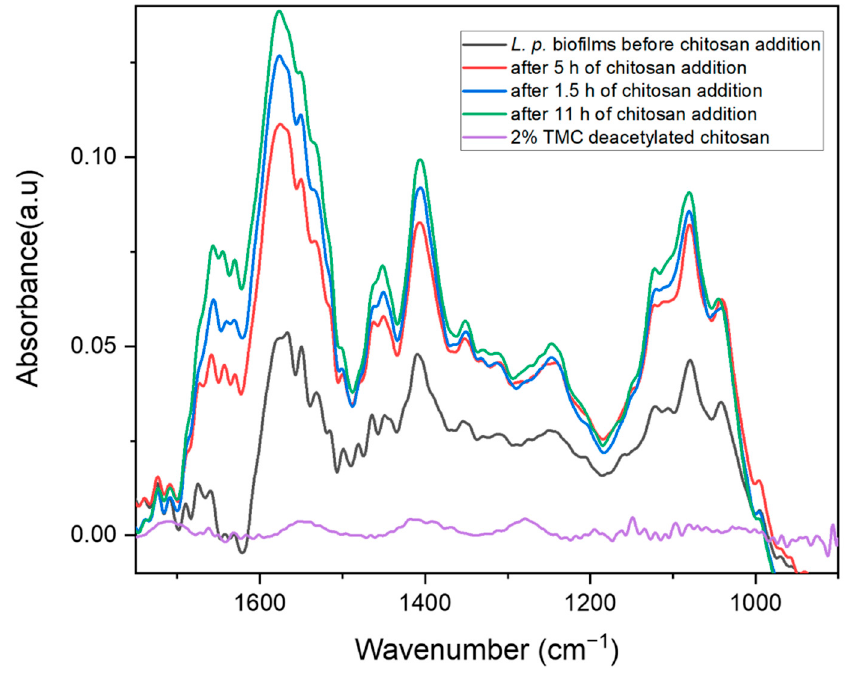
Figure 2. IR-ATR spectra of L. parab . biofilms with a 2% stock solution of chitosan in 1% acetic acid solution and MRS medium. The IR spectra were baseline-corrected.